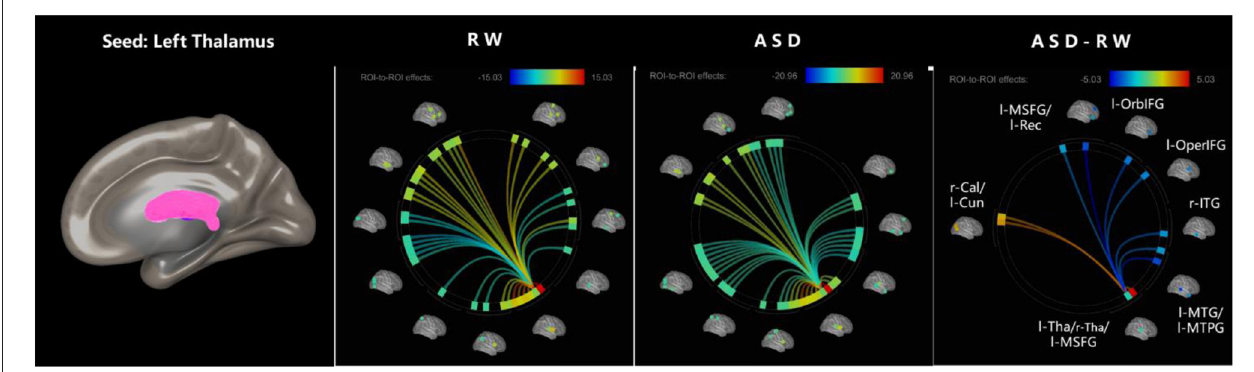
FIGURE 2 | ROI-to-ROI functional connectivity of left thalamus during RW, ASD, and ASD > RW conditions. False discovery rate-corrected ( p < 0.05) for ROI-to-ROI tests. The functional connectivity between l-Tha and l-OperIFG, l-OrbIFG, l-MTPG, l-Rec, l-MTG, and r-ITG decreased during ASD. The functional connectivity between l-Tha and l-Cun, r-Cal, l-MSFG, and r-Tha increased during ASD. l-MSFG, left medial superior frontal gyrus; l-MTPG, left middle temporal pole gyrus; l-OrbIFG, left orbital inferior frontal gyrus; l-OperIFG, left opercular inferior frontal gyrus; l-Rec, left rectus; l-MTG, left middle temporal gyrus; r-ITG, right inferior temporal gyrus; r-Tha, right thalamus; l-Cun, left cuneus; r-Cal, right calcarine; ROI, region of interest; ASD, acute sleep deprivation; RW, rested wakefulness.